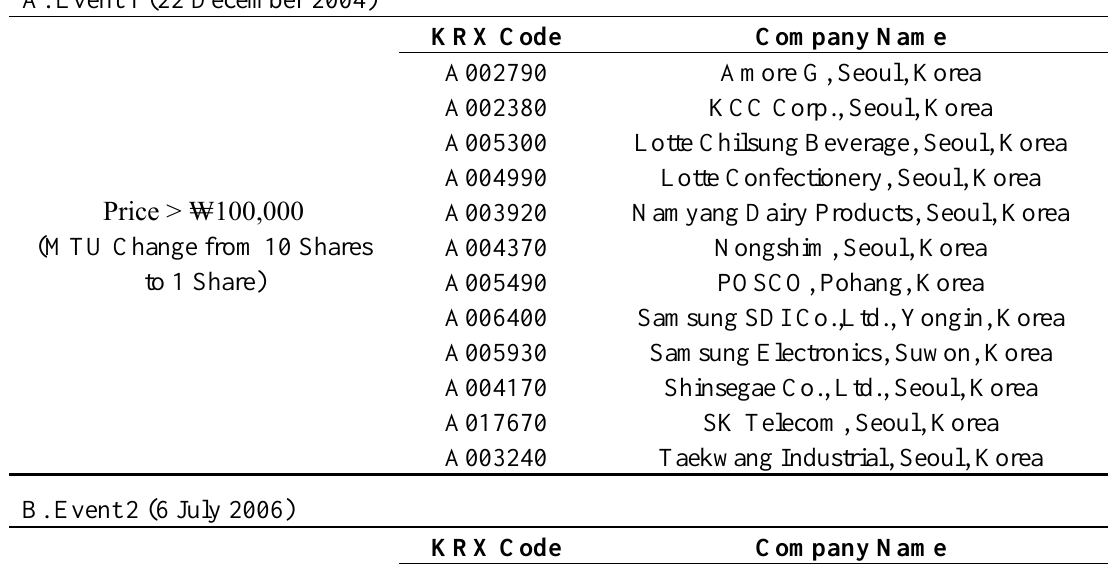
Table 1. List of Firms with minimum trade unit (MTU)